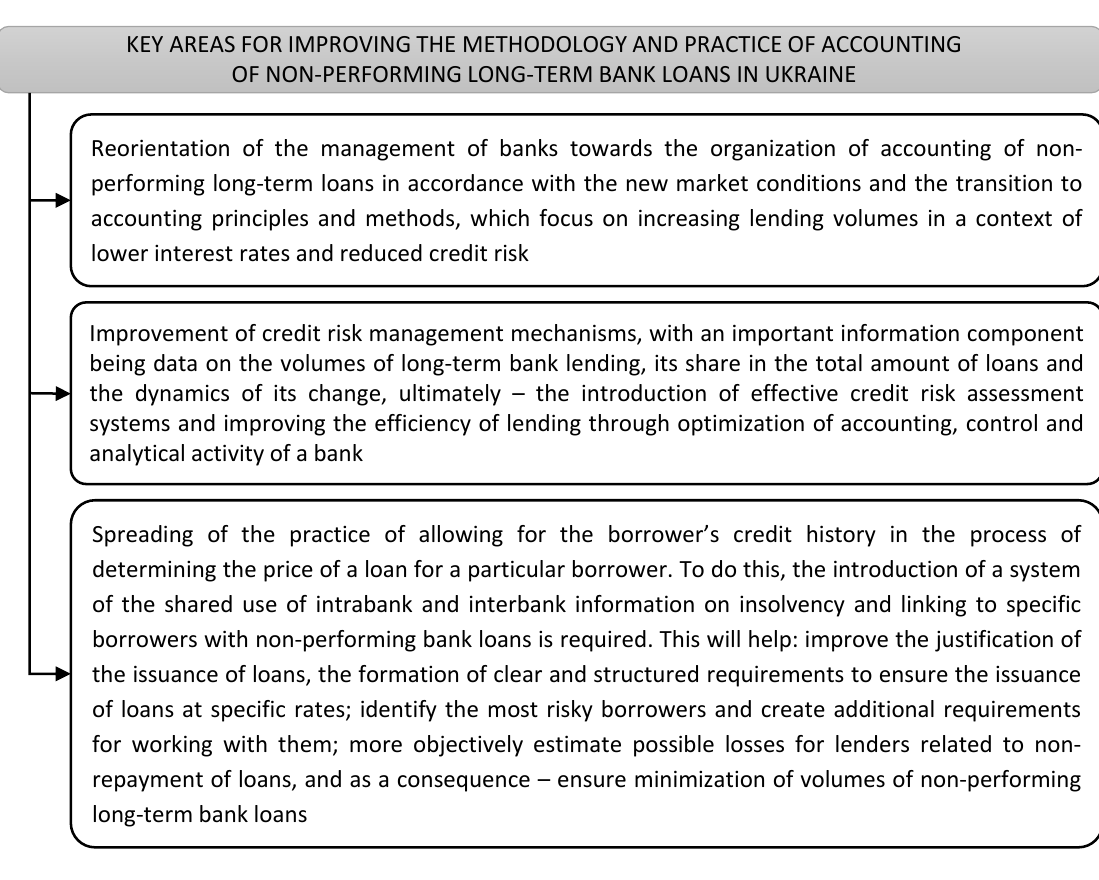
Figure 3. Ways of improving the methodology and practice of accounting of long-term bank loans in